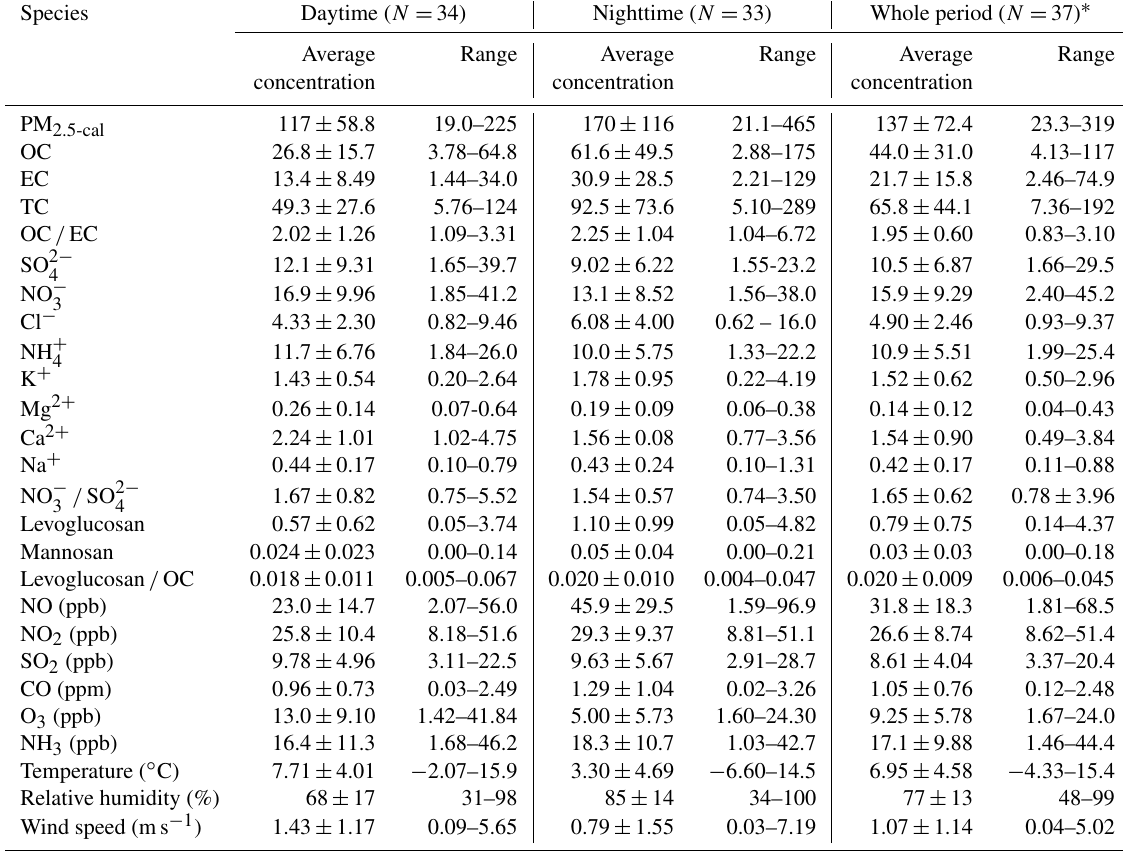
Table 1. Average concentrations and the range of PM 2.5-cal and its chemical components, biomass burning tracers (µgm − 3 ) , gaseous species, ratios of OC / EC and levoglucosan / OC, as well as meteorological data observed at the GC site during daytime, nighttime and the whole day, respectively, during the sampling period from 15 October to 23 November 2016.